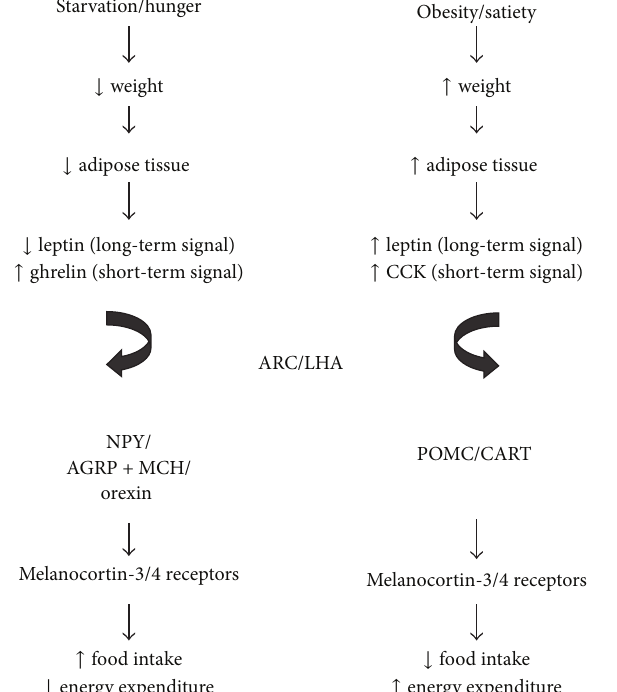
Figure 1: Starvation and satiety have opposing effects on levels of long-term (leptin, insulin) and short-term (ghrelin, CCK) signals that act on distinct neuronal populations within the hypothalamus. The effects of these neurons are mediated by melanocortin receptors and ultimately lead to increased or decreased intake based on the organism’s